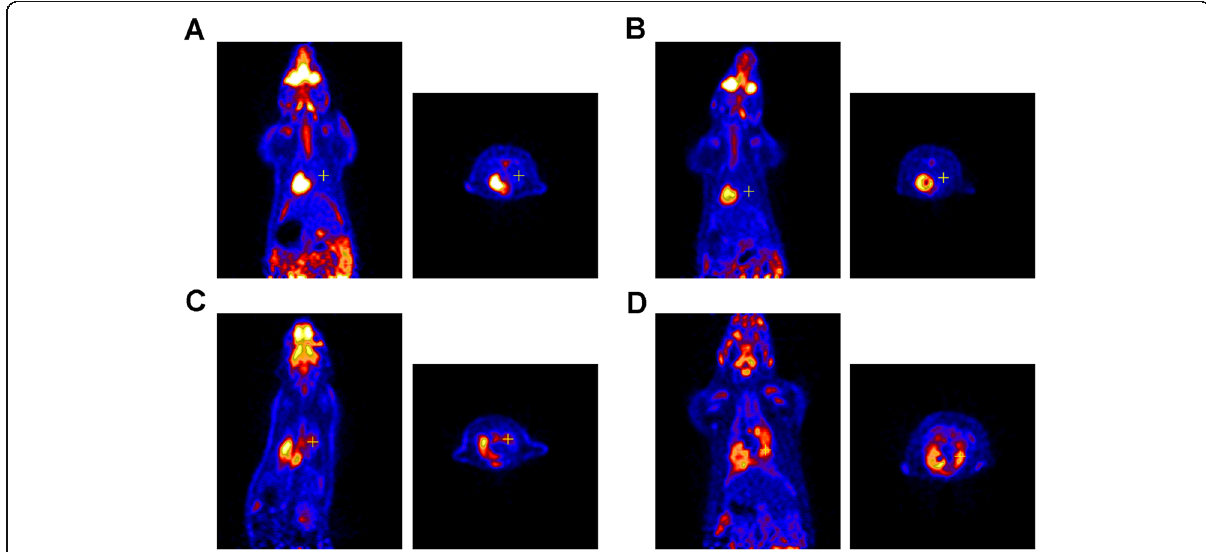
Fig. 2 Coronal (left) and cross-sectional scans of FDG uptake in the right lungs of rats in the control, radiotherapy (RT)-only, lipopolysaccharide (LPS)-only, and RT+LPS groups at 7 weeks after RT. No significant FDG uptake was observed in the control ( a ) or RT-only group ( b ), but FDG uptake clearly increased in the LPS-only ( c ) and RT+LPS ( d )